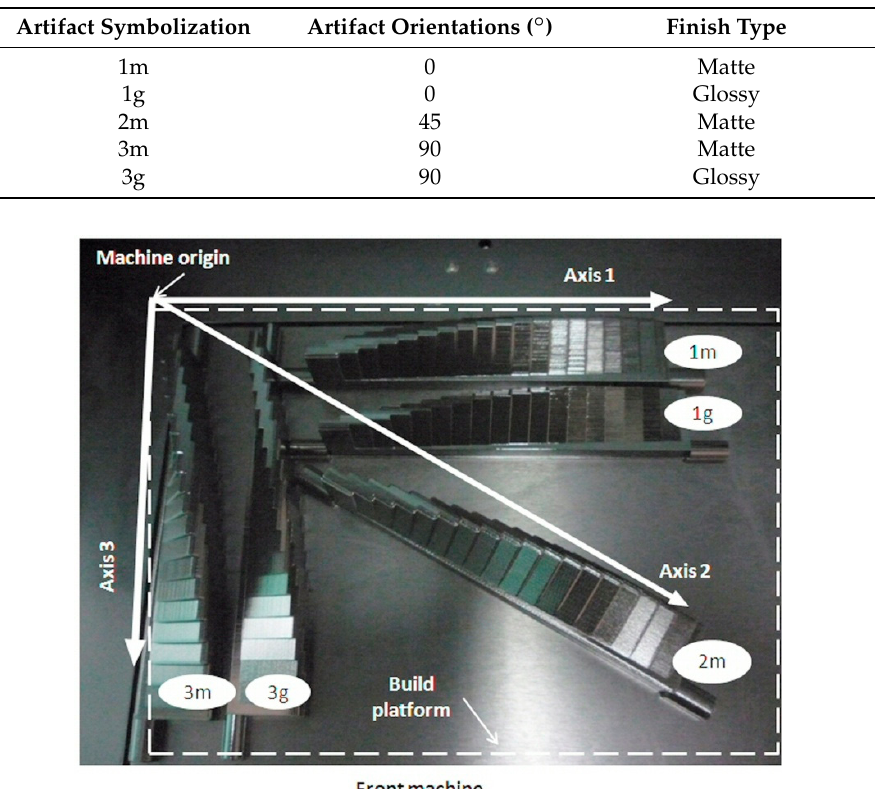
Figure 7. Layout of the EDEN 350 build platform illustrating the artifact samples in three different